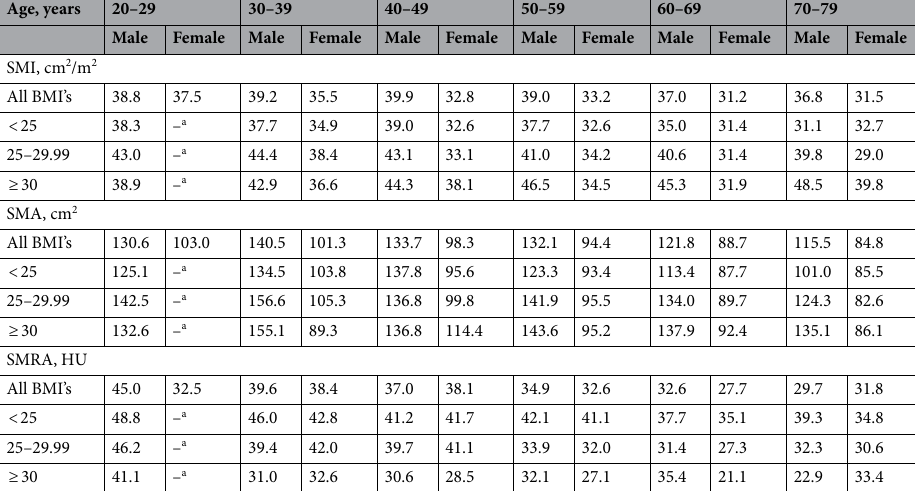
Table 3. Reference values (mean-2SD) for SMI, SMA, and SMRA, per age and BMI category. SMI skeletal muscle index (cm 2 /m 2 ), SMA skeletal muscle area (cm 2 ), SMRA skeletal muscle radiation attenuation